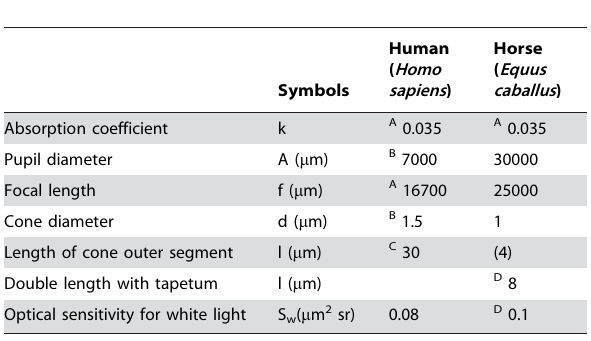
Table 1. The optical sensitivity for the cones of the human eye and the horse eye at intensities corresponding to moonlight.